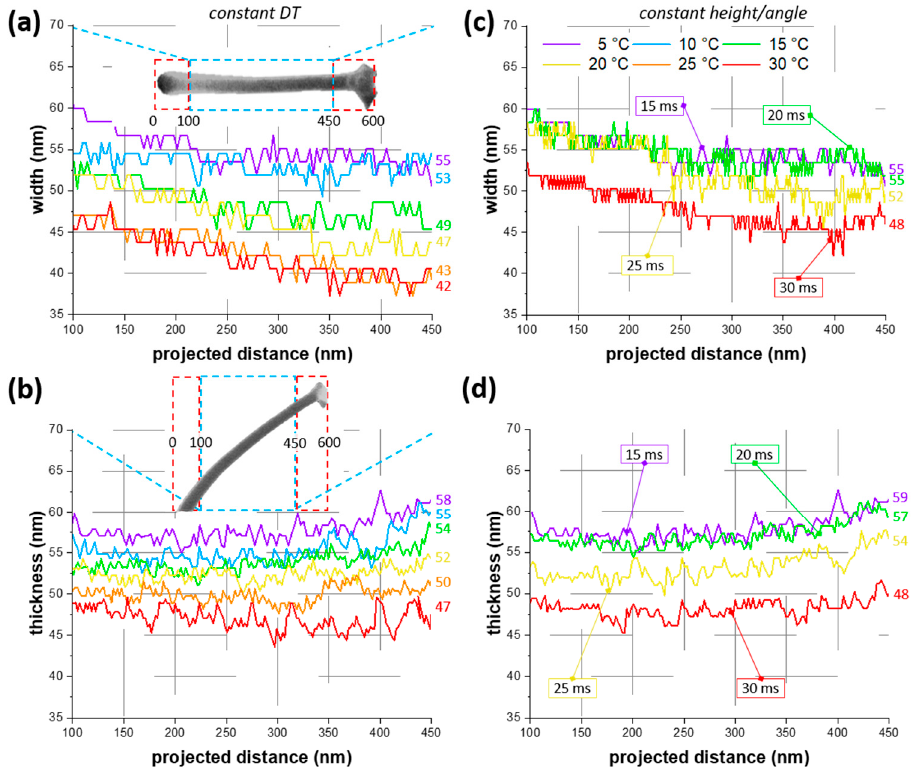
Figure 2. Width and thickness variations along the wires of a tripod. ( a ) Width and ( b ) thickness fabricated at a constant dwell time of 15 ms as a function of the wire length. The insets show a tripod leg in the ( a ) top and ( b ) 52 ◦ tilted view, where red boxes indicate which regions are excluded. ( c , d ) show the widths and thickness for tripods with nearly constant heights/angles. Values in the colored boxes specify the required dwell times for tripod fabrication. The colored numbers at the right of each graph show the mean values for thickness and width, respectively. The legend in ( c ) applies to all graphs.